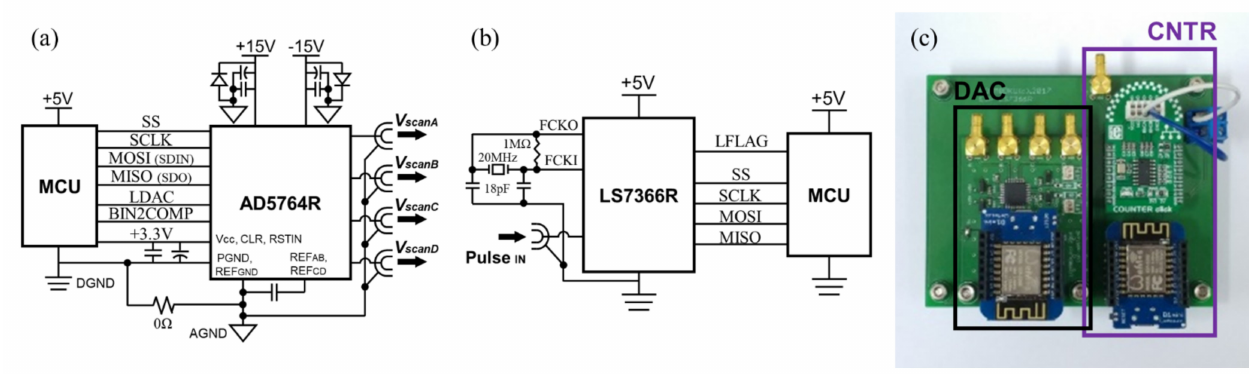
Figure A2. Electronic schematics for ( a ) the digital-to-analog converter (DAC) circuit and ( b ) the pulse counter (CNTR) circuit. ( c ) A photograph of the combined circuit boards for the 3D scanner module and the photon counter module.